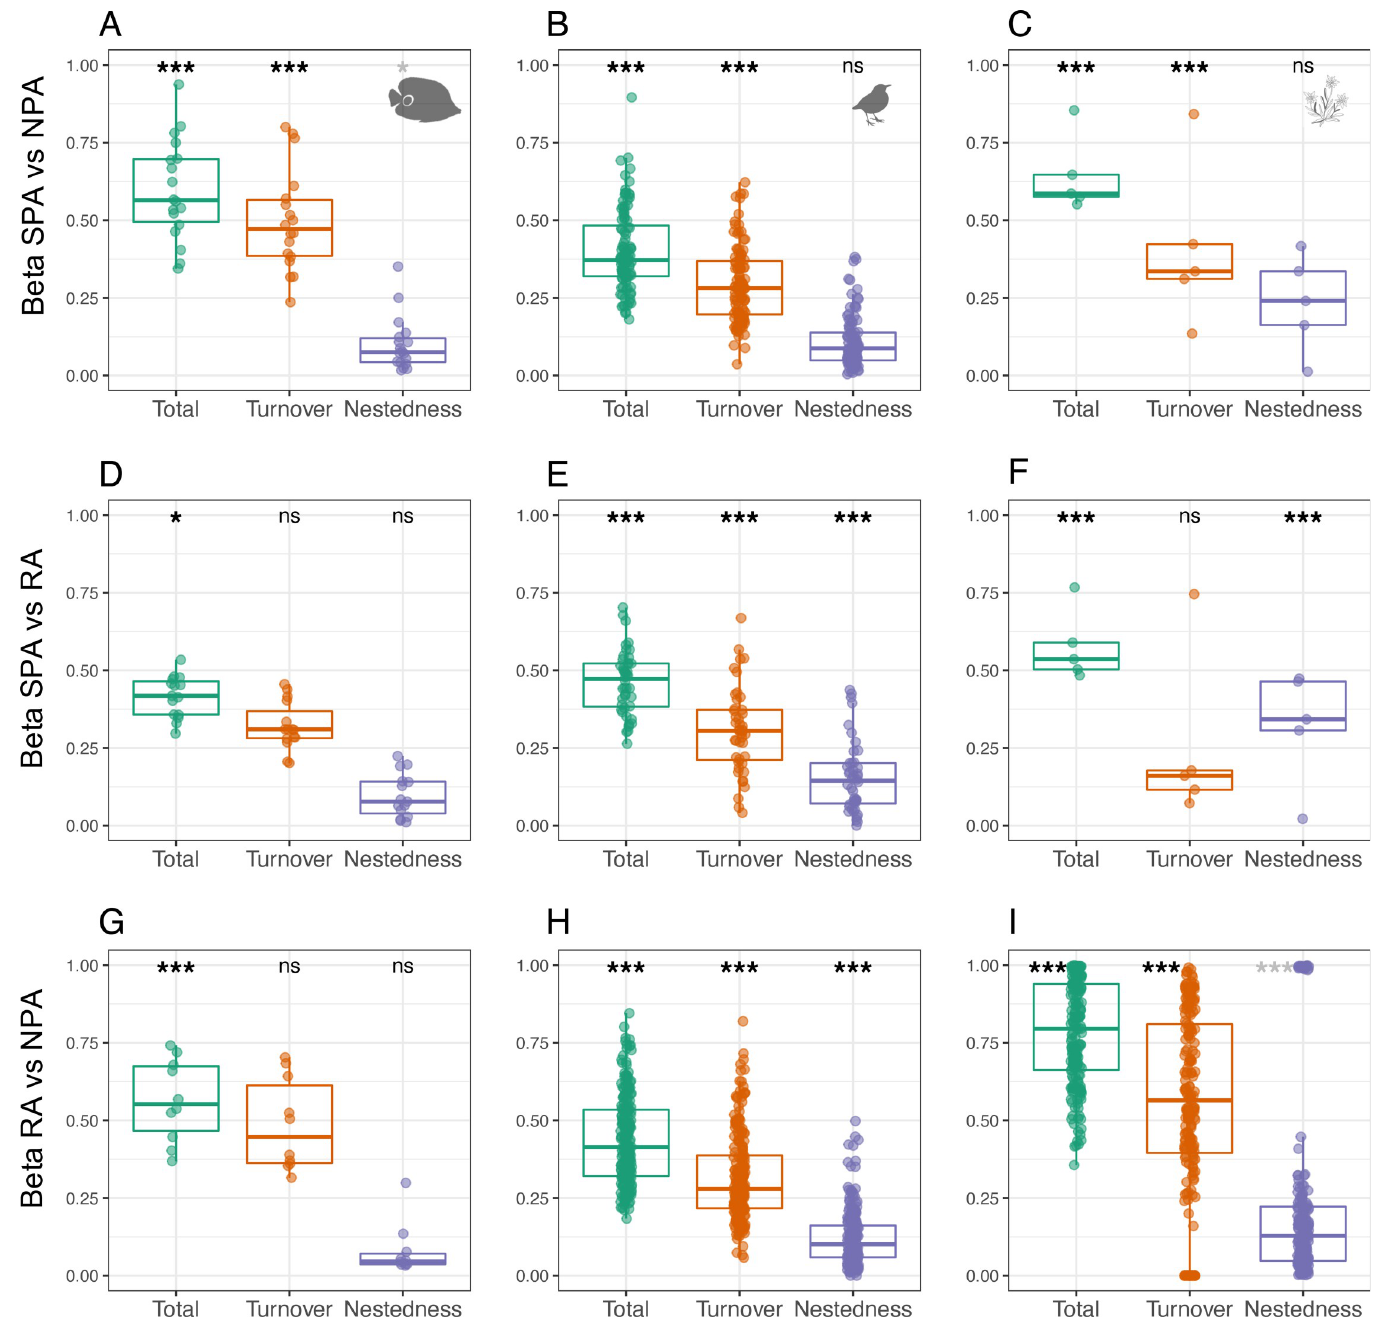
Fig 5. Species dissimilarity and its partitioning components of turnover and nestedness between SPA, RA, and NPA in surrounding areas within a buffer of 50 km, after controlling for the number of surveys inside each protection level for reef fishes ( A, D, G ), birds ( B, E, H ), and alpine plants ( C, F, I ). Asterisks indicate the Fisher p -value, denoting the probability that the observed combination of dissimilarity values and their partitioning components are different from a random allocation species to surveys; when values of ß-diversity are higher than a random allocation of species to surveys asterisks are in black while for ß-diversity values lower of lower values are in gray (S2 Fig). ��� p -value < 0.01, �� p -value < 0.05, � p -value < 0.1. The raw data can be found in https://github.com/LoiseauN/Betadiversity-protected-areas. NPA AU : AnabbreviationlisthasbeencompiledforthoseusedinFig 5 : Pleaseverifythatallentriesarecorrect : Inaddition ; pleasedefine � ns � inFig 5 abbreviationlistifthisindeedisanabbreviation : , Non-Protected Areas; ns, non significant; RA, Restricted Areas; SPA, Strictly Protected